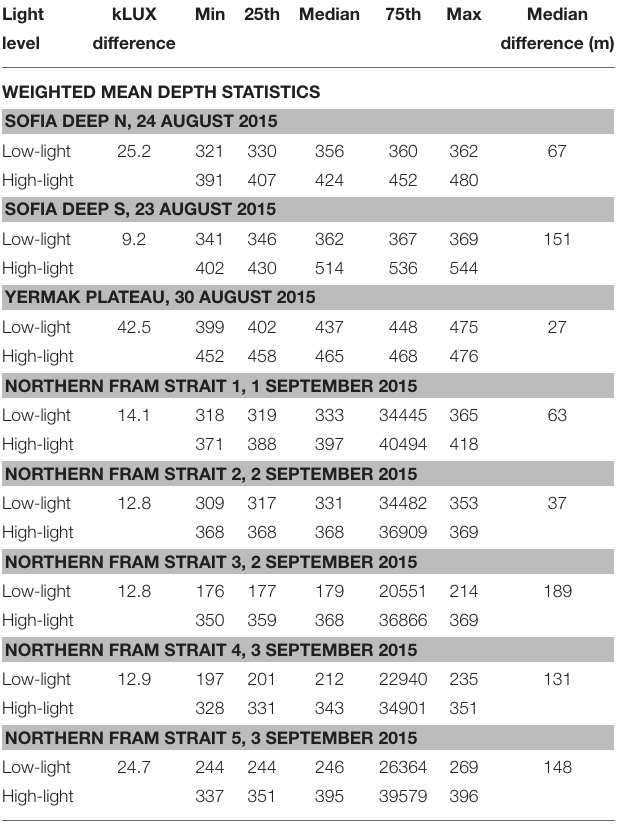
TABLE 2 | Weighted mean depth (m) statistics for the four time periods.